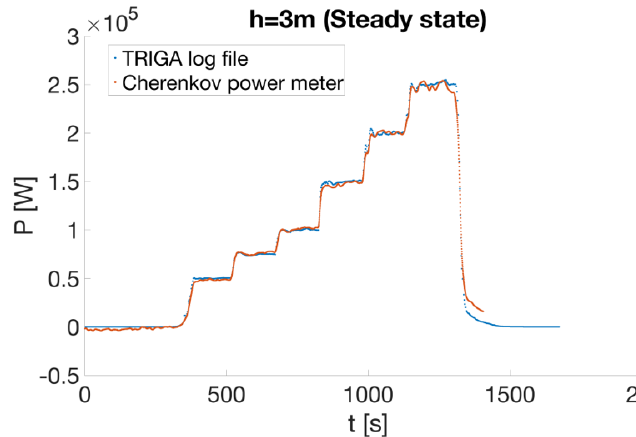
Fig. 10. Measured SiPM signal and reactor power as a function of time, for steady state reactor operation.